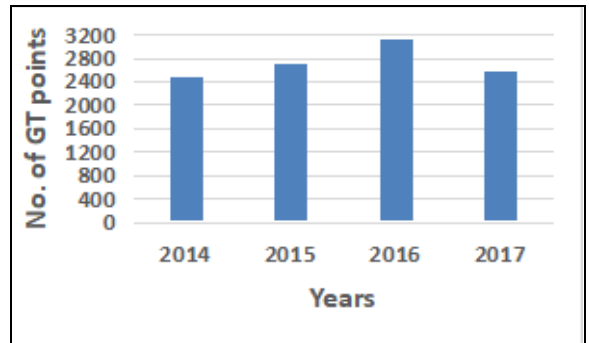
Figure 4. Ground truth data collected for different